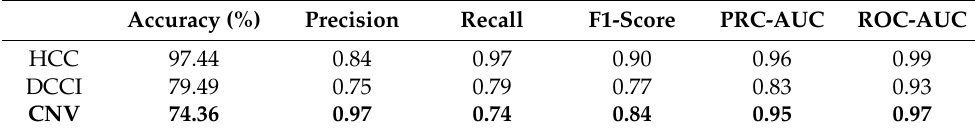
Table 3. CNV screening performance of the original VGG19. Accuracy, precision, recall, F1-score, area under the curve (AUC) for precision-recall (PRC) and receiver operation characteristic (ROC) curves for the three classes of OCTA images (HCC: healthy choriocapillaris, DCCI: drusen/choriocapillaris impairment, CNV: choroidal